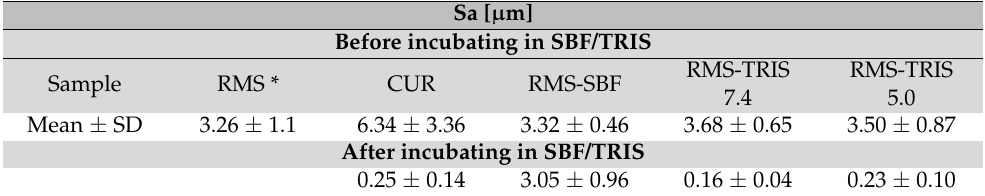
Figure 4. 3D laser scanning microscopy images of the surface of ( a ): RMS and ( b ): Curasan Ceram- ics, Inner surface after incubation in TRIS buffer pH 7.4 for 60d ( c ): RMS and ( d ): Curasan ceram- ics; white bar represents 10 µm, Images taken with KEYENCE VK-X210 .